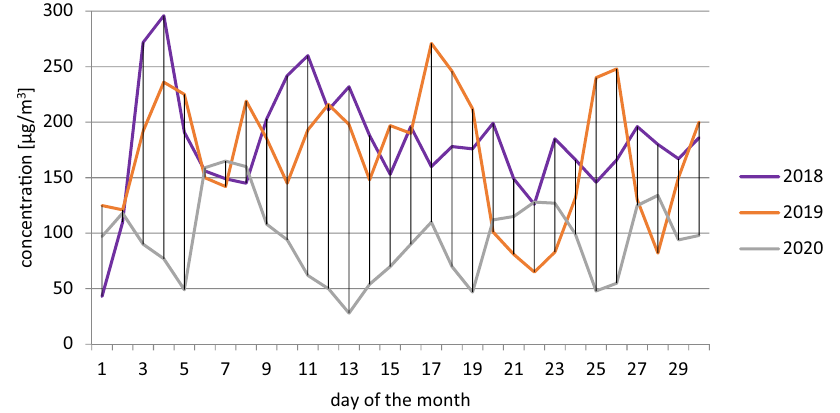
Figure 3: Average daily concentration of NO x in the air in Krakow on Krasinskiego Avenue in April 2018 – 2020. Source: own study based on data from ref. [ 25 ]